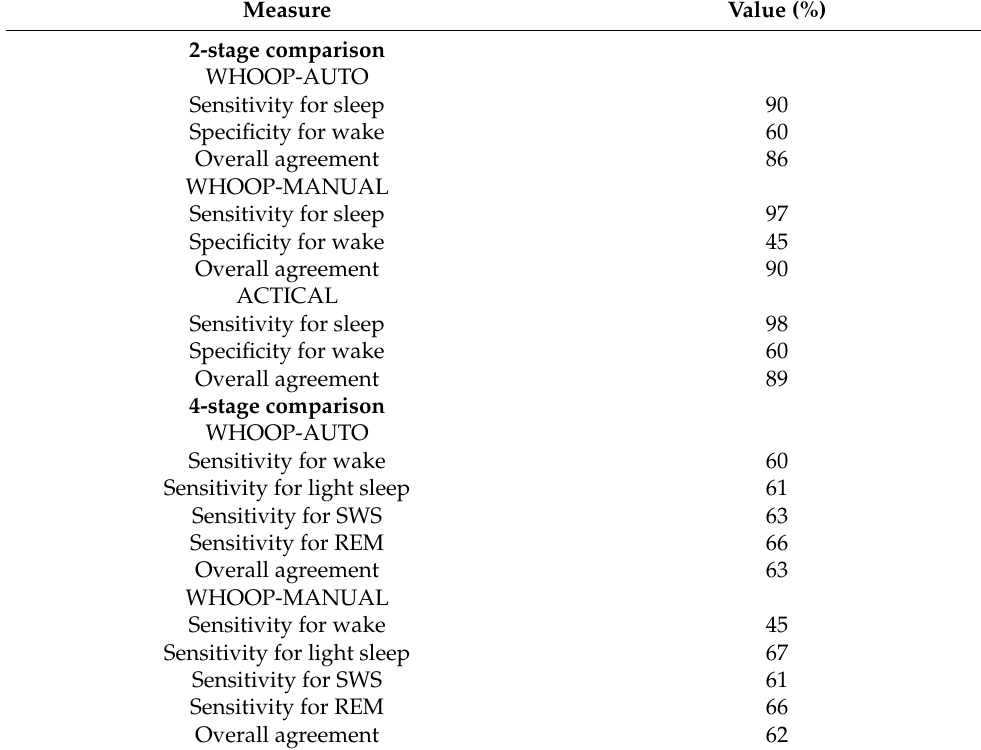
Table 2. Epoch-by-epoch concordance statistics for WHOOP-AUTO (2-stage and 4-stage categori- sation of sleep), WHOOP-MANUAL (2-stage and 4-stage categorisation of sleep) and ACTICAL (2-stage categorisation of sleep) against